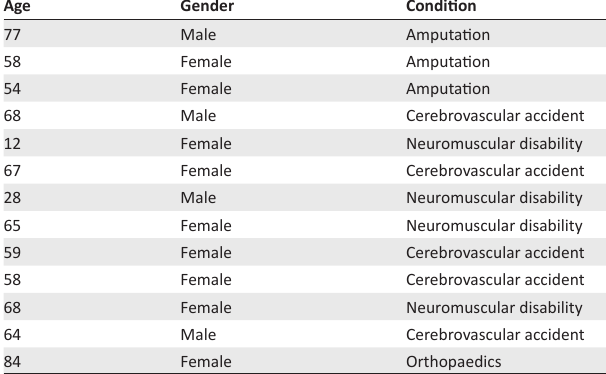
TABLE 1b: Patient